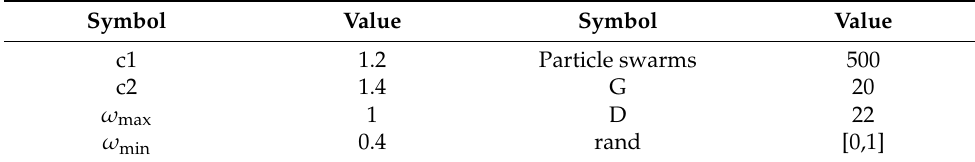
Table 2. Key parameters of the PSO algorithm. Symbol Value Symbol Value c1 1.2 Particle swarms